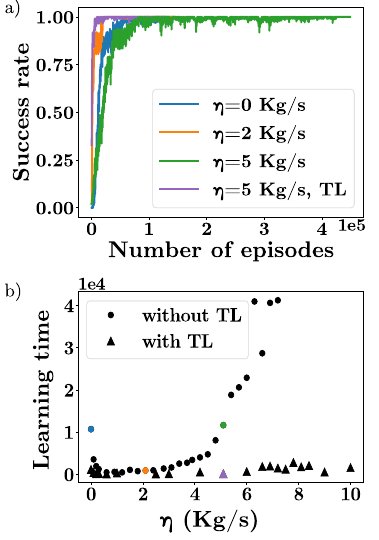
Fig. 2 Training dynamics of the reinforcement learning agent. The training is done on the model presented in Fig. 1 with different values of the viscous coef fi cient. a Evolution of the success rate over a sliding span of 100 episodes during training. For the blue, green, and orange curves, the arti fi cial neural network (ANN) was initialized randomly. For the purple curve, the ANN was initialized using the weights of a previously model trained with η = 4 kg s − 1 . b Learning time against the viscous coef fi cient with and without transfer